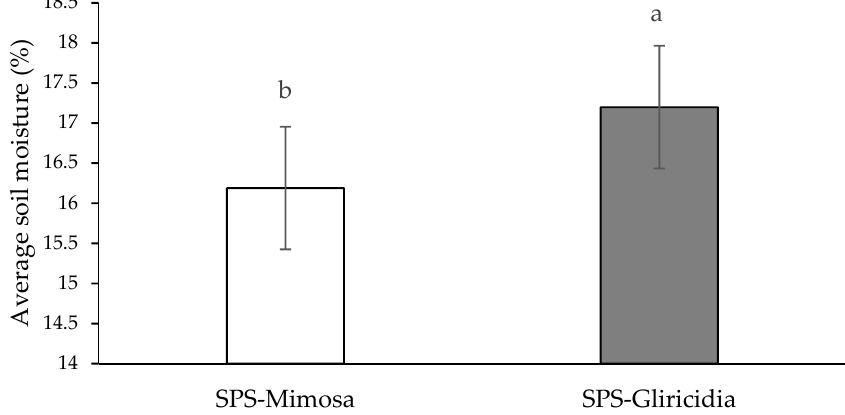
Figure 7. Average soil moisture in Mimosa and Gliricidia silvopasture systems. Values are averages across